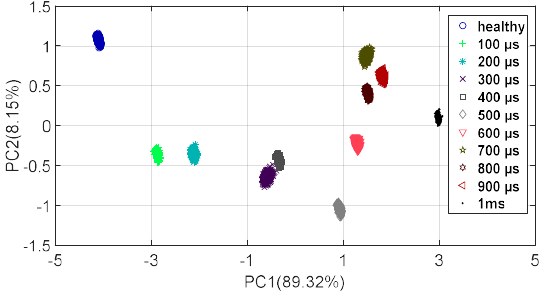
Figure 20. PCA results for 60 rad / s motor speed at a rated